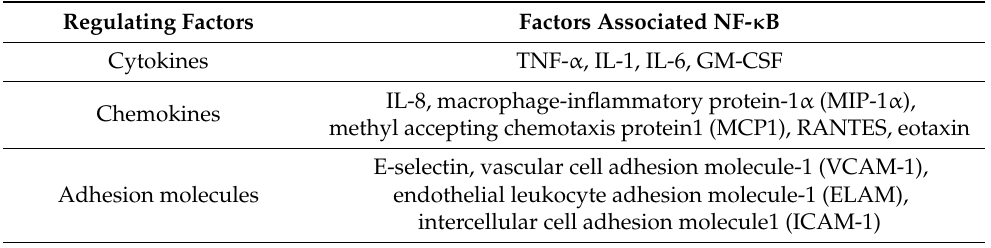
Table 4. The factors associated nuclear factor kappa B (NF- κ B) signal.